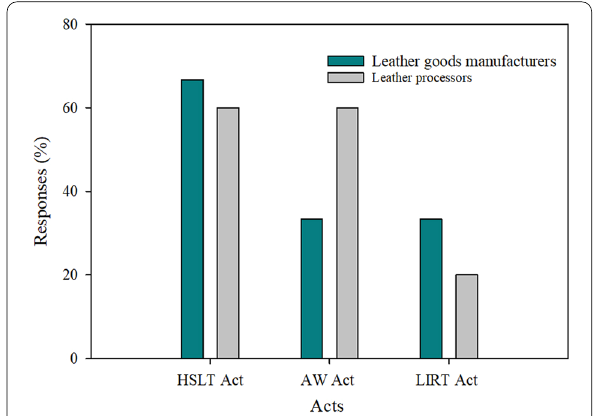
Fig. 7 Acts regulating the leather sector in Tanzania (HSLT Act is Hides, Skins and Leather Trade Act No. 18 of 2008; AW Act is Animal Welfare Act No. 19 of 2018; LIRT Act is Livestock Identification,